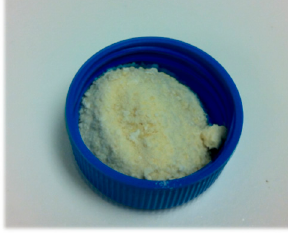
Figure 8. Freeze-dried cellobiose-rich product from enzymatic hydrolysis of pretreated birch.